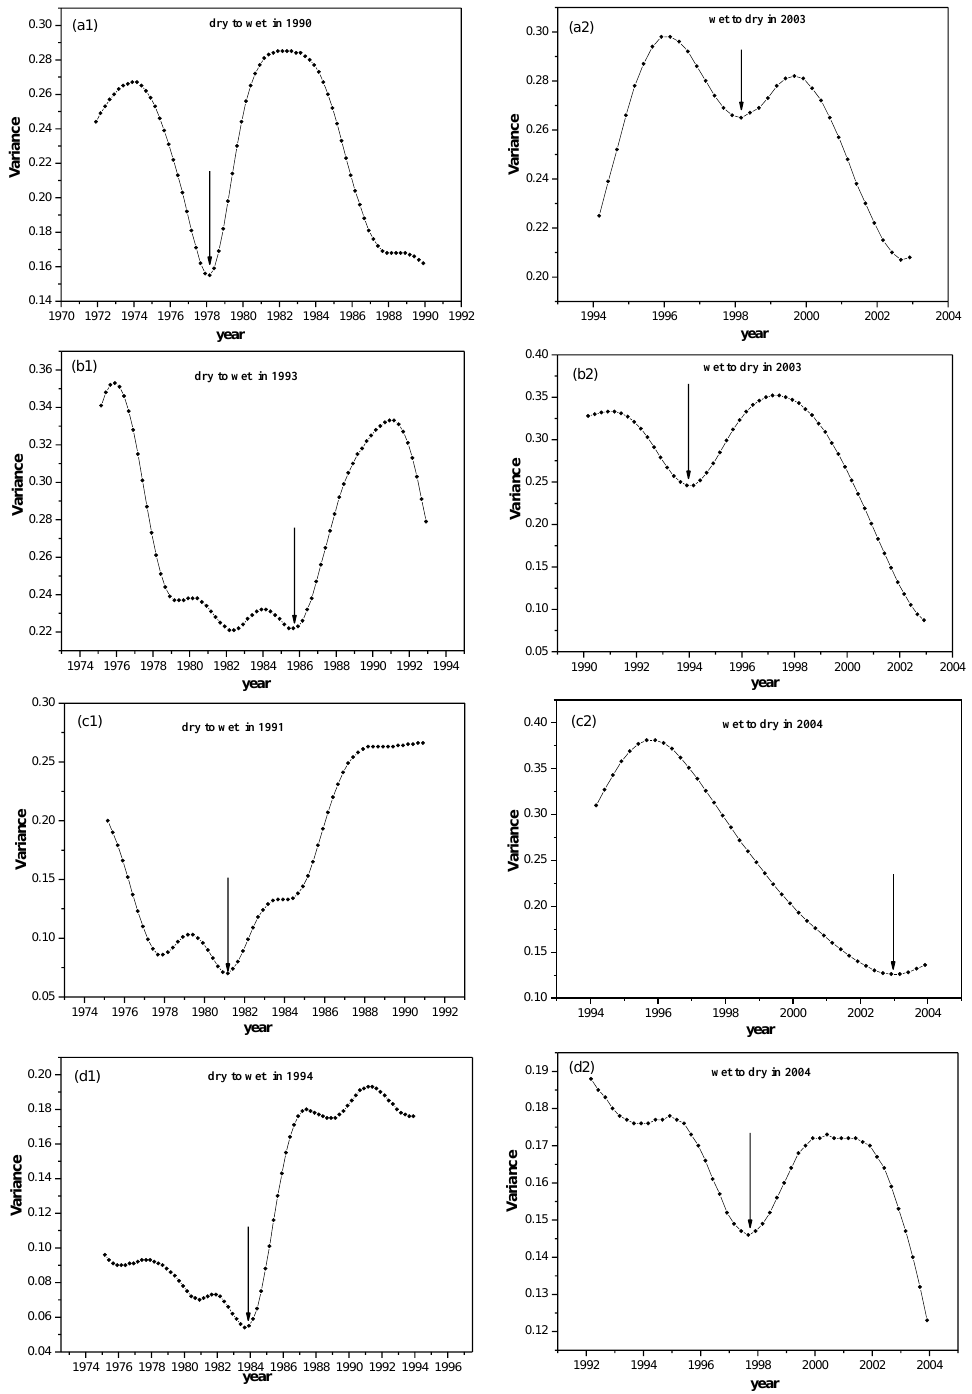
Figure 5. Variance signal-based detection of DWT in different sub-regions of the two-lake region, where ML is set to 10 years, and MT is set to 3 months for the sliding window. ( a1 – d2 ) correspond to four different sub-regions. The left and right figures correspond to the two DWT events in the early 1990s and early 2000s, respectively.